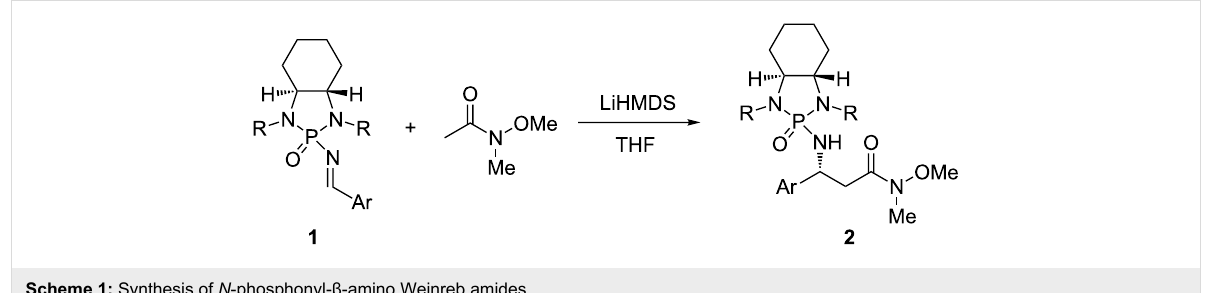
Scheme 1: Synthesis of N -phosphonyl- β -amino Weinreb amides.